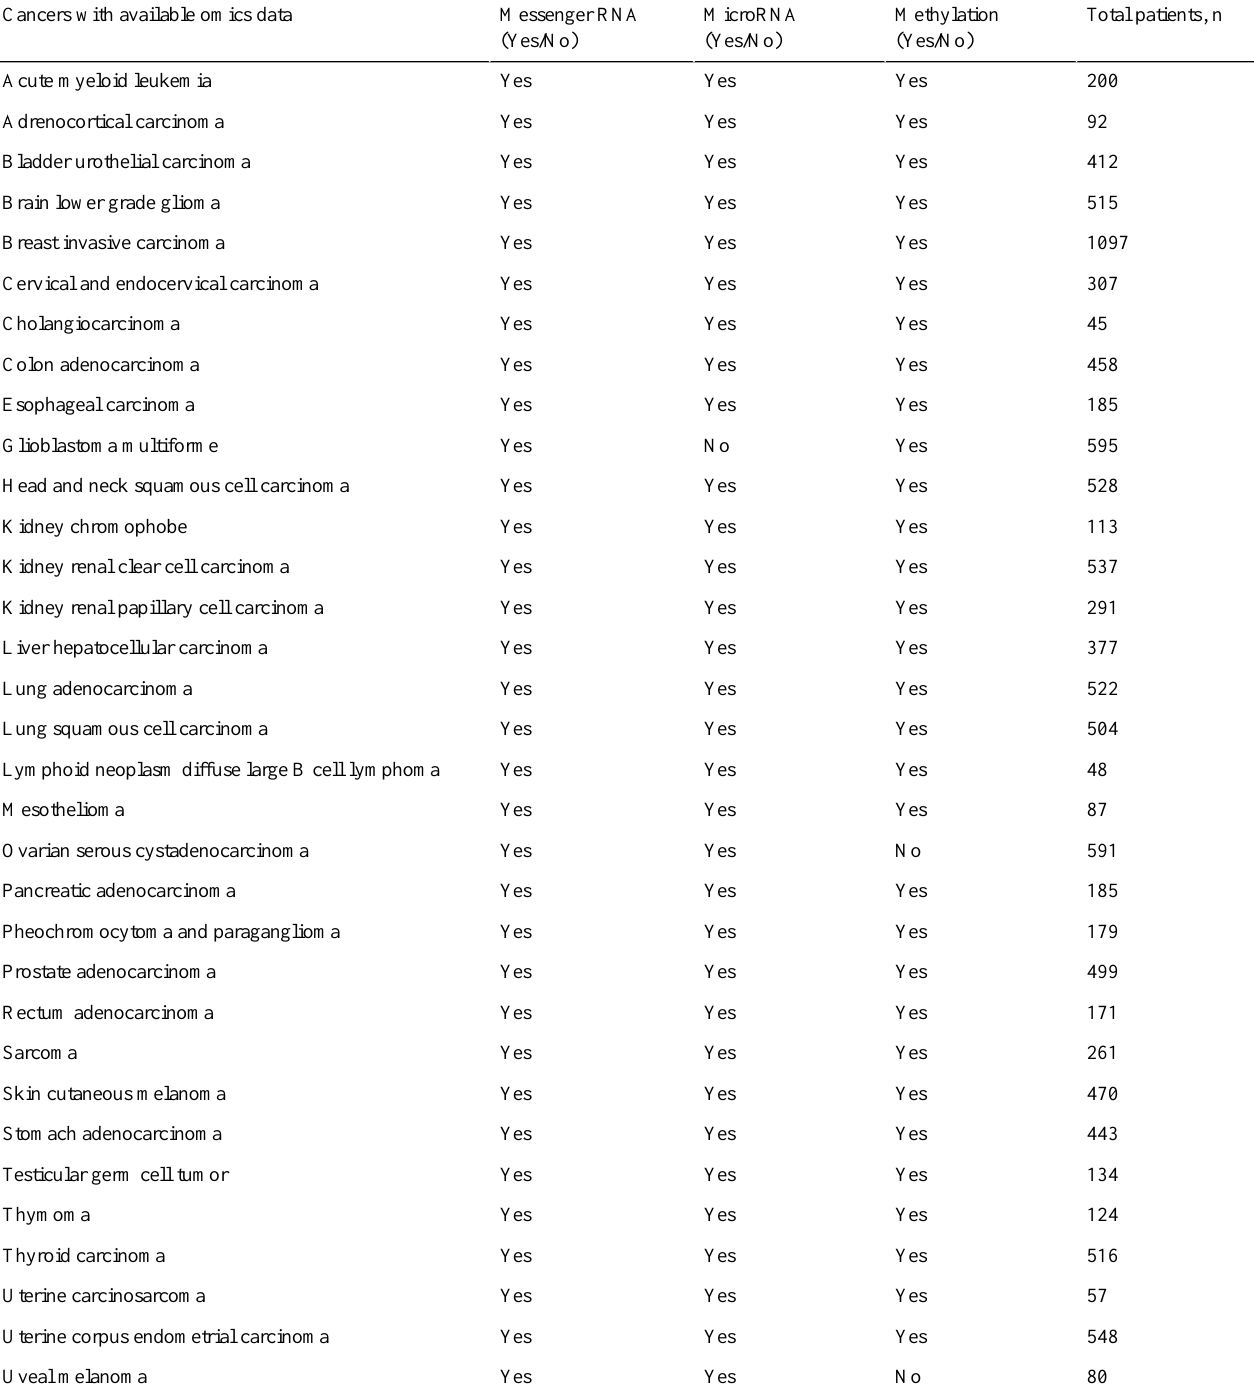
Table 1. Summary of the data available in the